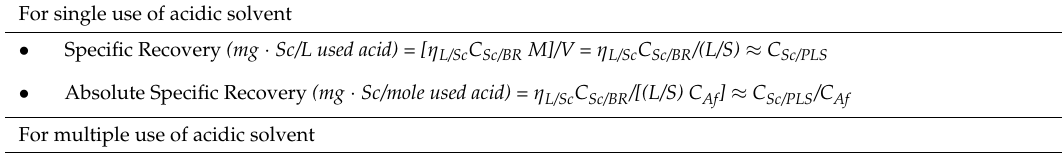
Table 1. Definitions of Specific Recovery for the Acidic Leaching of the Greek BR.